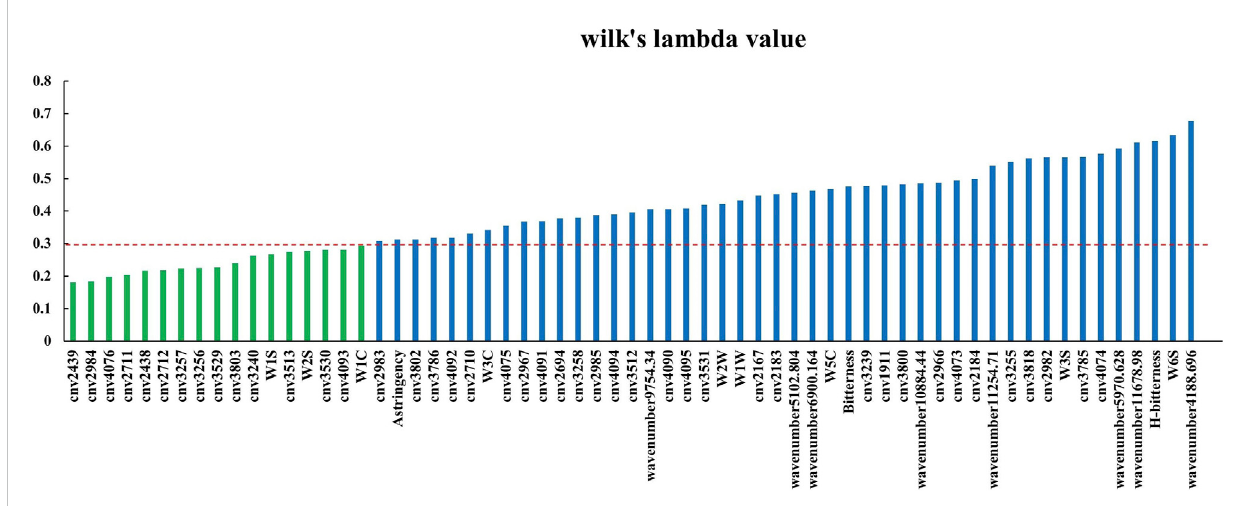
FIGURE 10 Wilk ’ s lambda value of original variables in the four-source data fusion PCA-DA model (cnv: color number